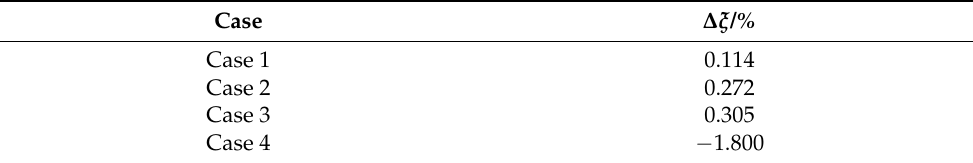
Table 4. Non-dimensional total pressure loss